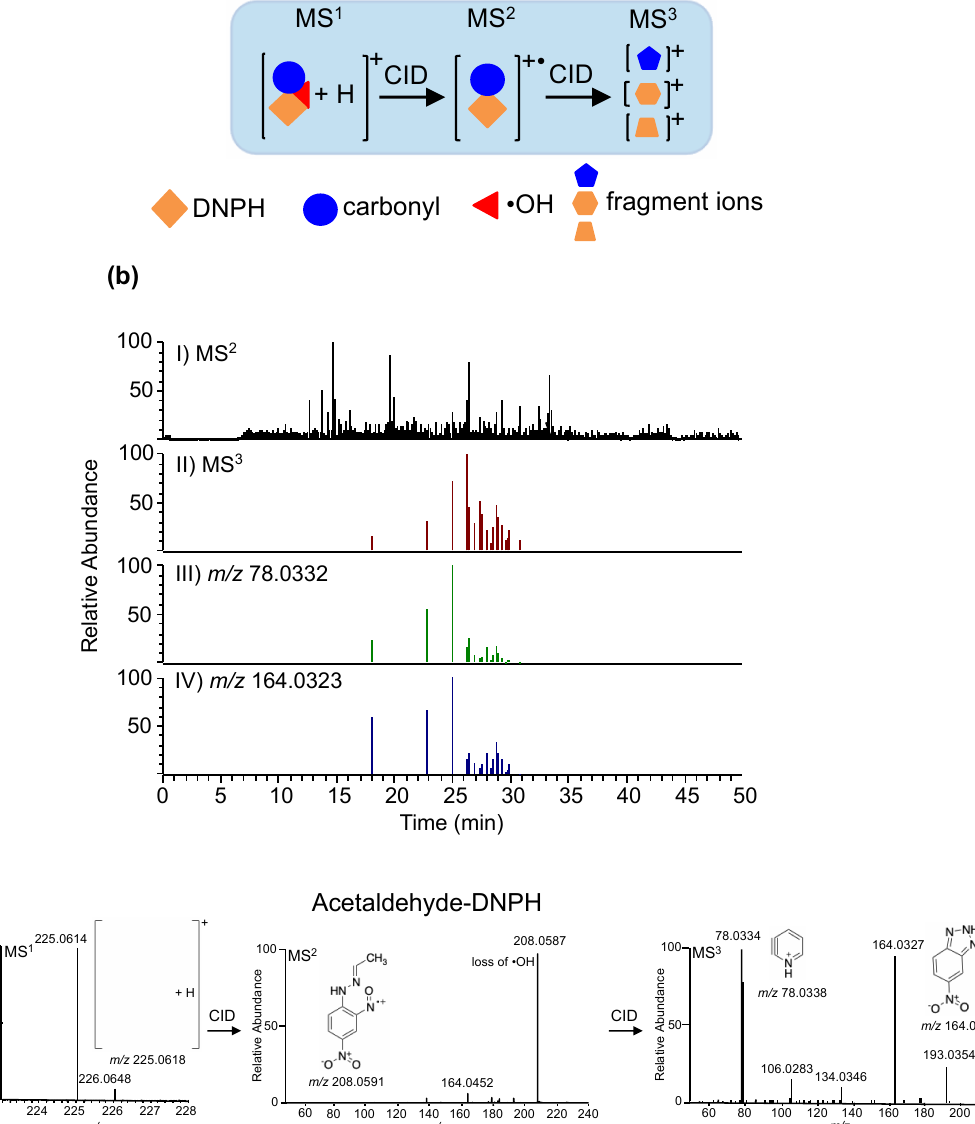
Figure 7. Development of a high-resolution accurate mass data-dependent MS 3 neutral loss screening strategy for profiling and quantitative analysis of aldehydes in biological fluids. ( a ) The high-resolution accurate mass of • OH (17.0027 Da) was used to screen for all DNPH-derivatized aldehydes. ( b ) Monitoring of specific fragment ions ( m / z 78.0332 and m / z 164.0323) minimizes possible false positive identification. ( c ) Representative MS, MS 2 , and MS 3 spectra of DNPH-derivatized acetaldehyde and proposed structures of major fragment ions. Reprinted with permission from Ref. [218] (Copyright 2017, Springer).